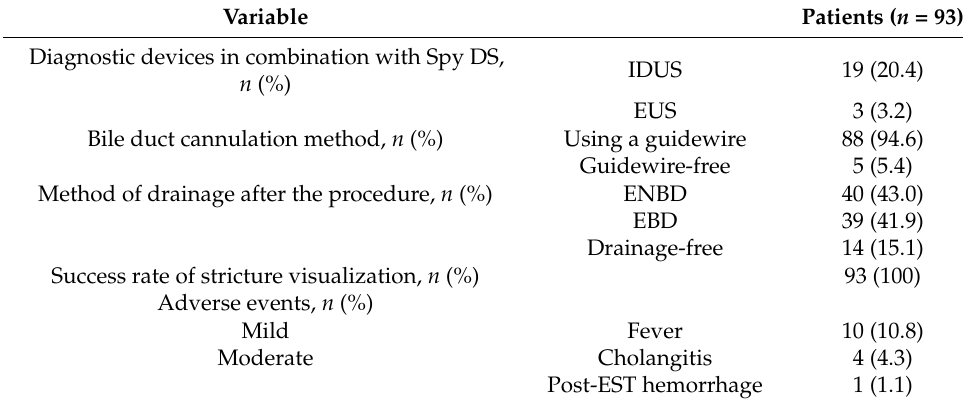
Table 3. Clinical outcomes of diagnostic procedures by Spy DS. Variable Patients ( n =